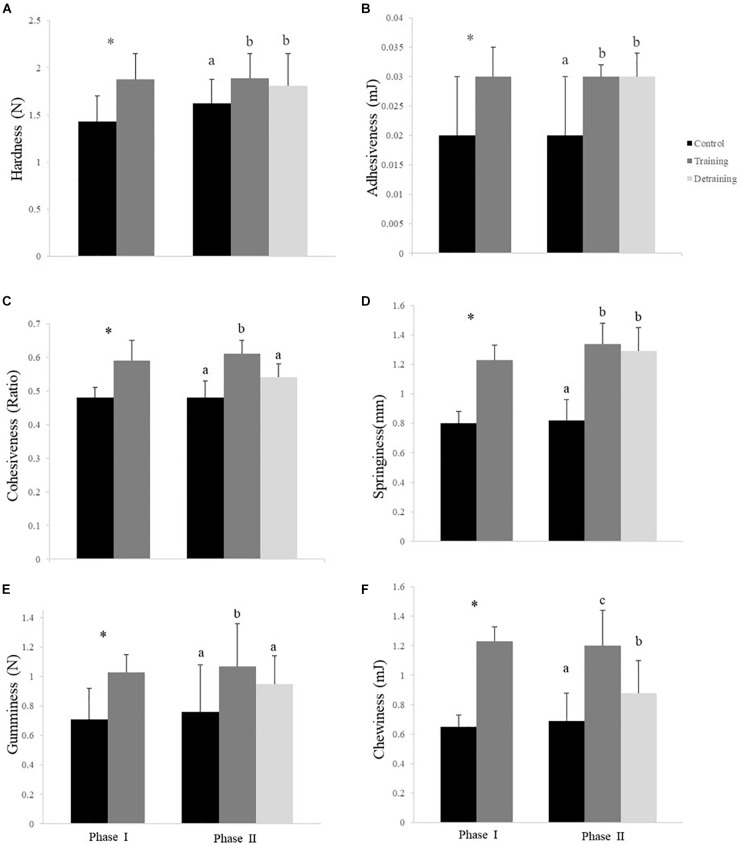
Hardness (A), adhesiveness (B), cohesiveness (C), springiness (D), gumminess (E), and chewiness (F) (mean ± SD) in the flesh of the experimental fish (n = 12). ∗Significant differences between the control and training groups in Phase I; different letters indicate significant differences among control, training, and detraining groups in Phase II (P < 0.05).